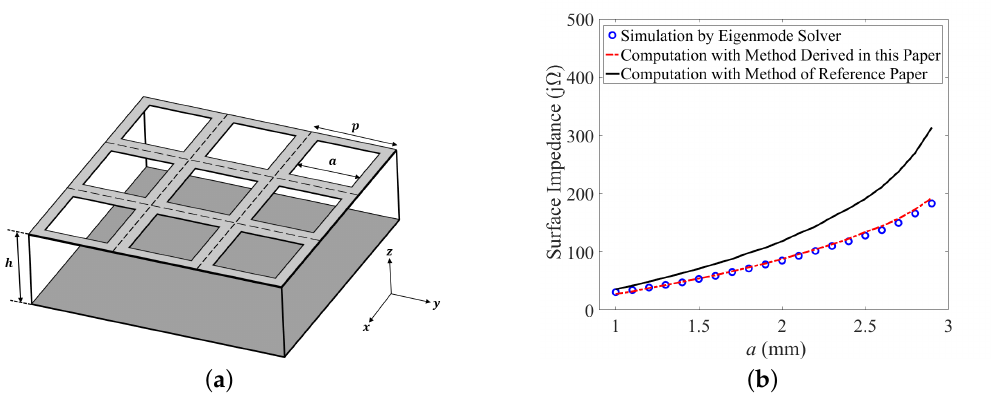
Figure 19. Dual-layer metasurface with periodic square apertures at top and ground plane at bottom: ( a ) configuration of surface with p = h = 3 mm ( b ) comparison between simulated and computed TM-polarized surface impedance of surface-wave mode at 10